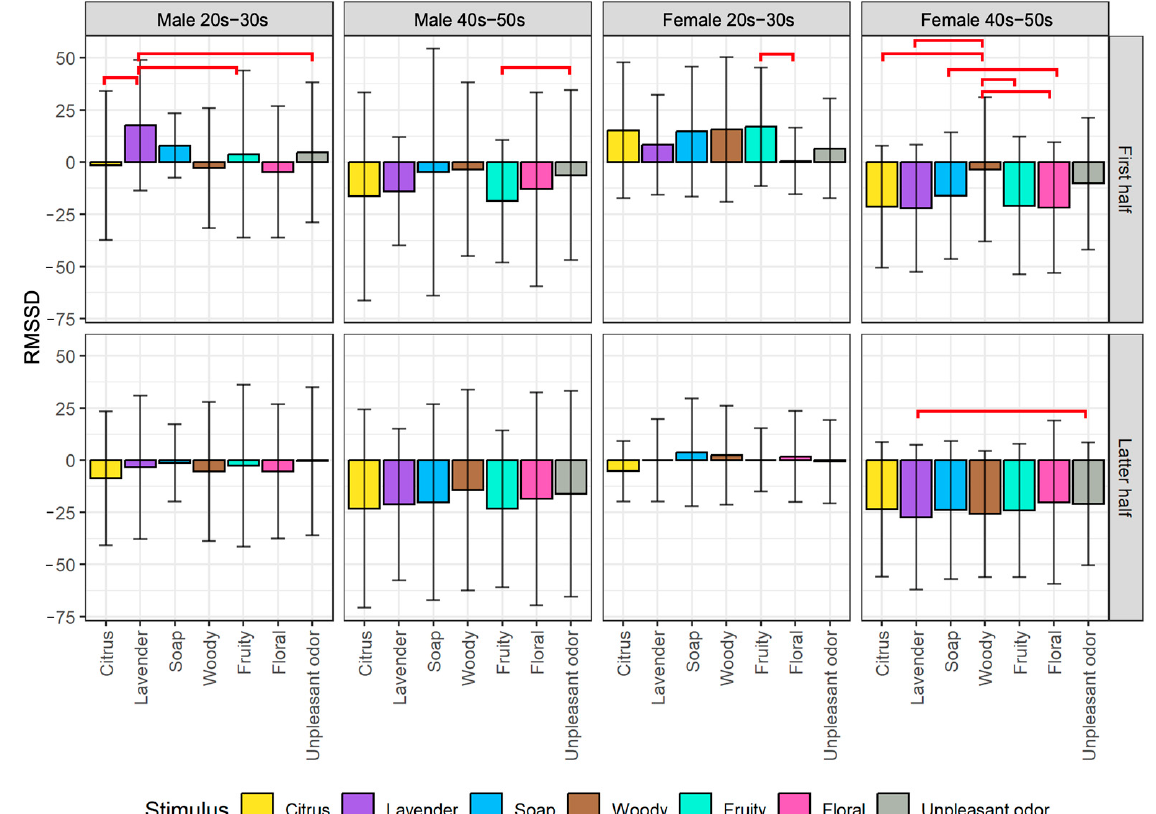
Figure 9. Comparison of changes in RMSSD among stimuli by gender and generation groups divided into the first half (top) and latter half (bottom) of stimulus exposure time. The red lines indicate significant differences between pairs of stimuli.